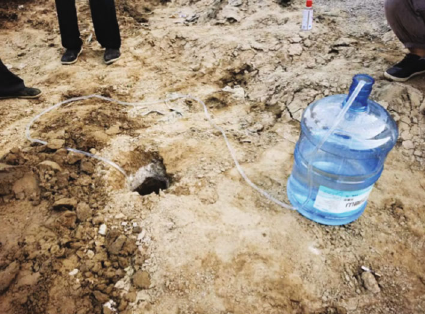
Figure 2: Field exploration operation chart. Figure 3: Field water injection operation Figure 2. The soil samples are taken within 30 cm above the bottom of the pipe gallery and sent to the laboratory to carry out triaxial tests. After the sampling is completed, the drilling rig withdraws.